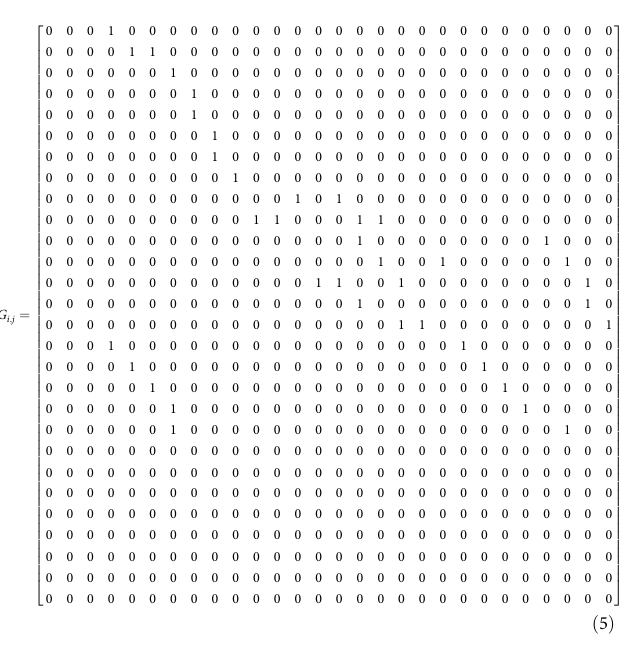
To generalize the process design, we de fi ne the superstructure (which contains all possible combinations of electrochemical processes) and reduce it using algorithm in Table 2 for the chosen products (Fig. 3, Supplementary Figs. 2 and 7). The prede fi ned electrochemical process superstructure matrix G i ; j 2 Z N ´ Z N , i ; j 2 U : ¼ f 1 ; ¼ ; N g is de fi ned as